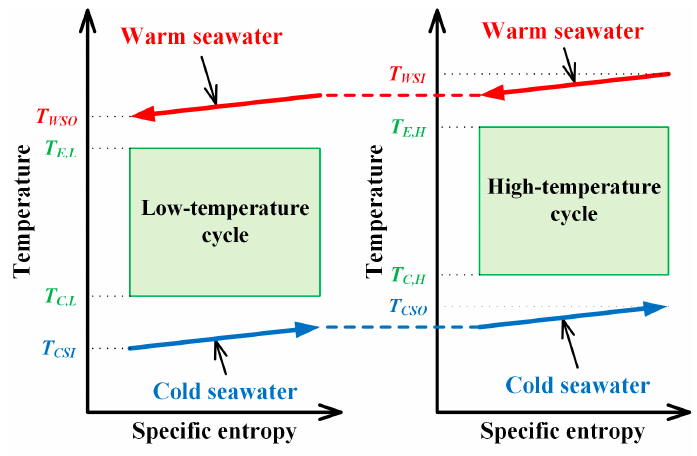
Figure 3. Double-stage Rankine cycle flow. J. Mar. Sci. Eng. 2018 , 6 , x